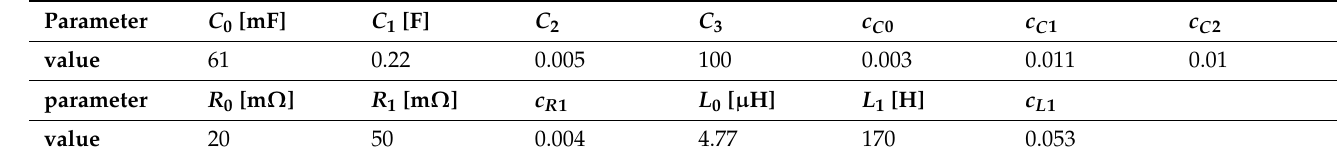
Table 3. Values of the parameters occurring in Formulas